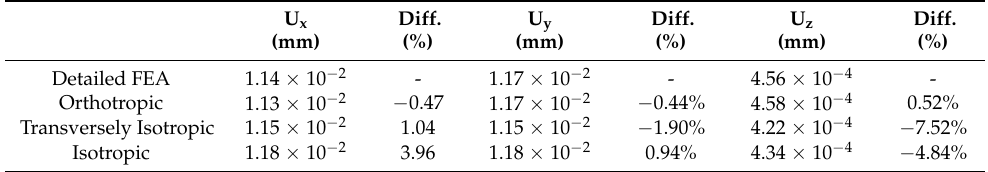
Table 4. Comparison of calculated thermal deformations among three different constitutive models. U x (mm)